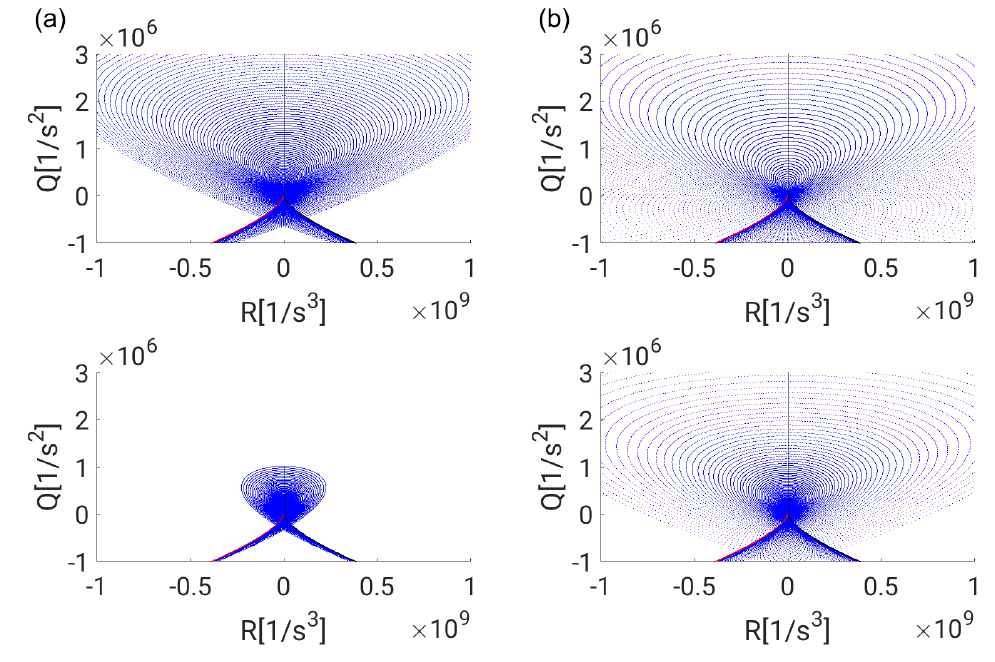
Figure 15. Magnified view of Figure